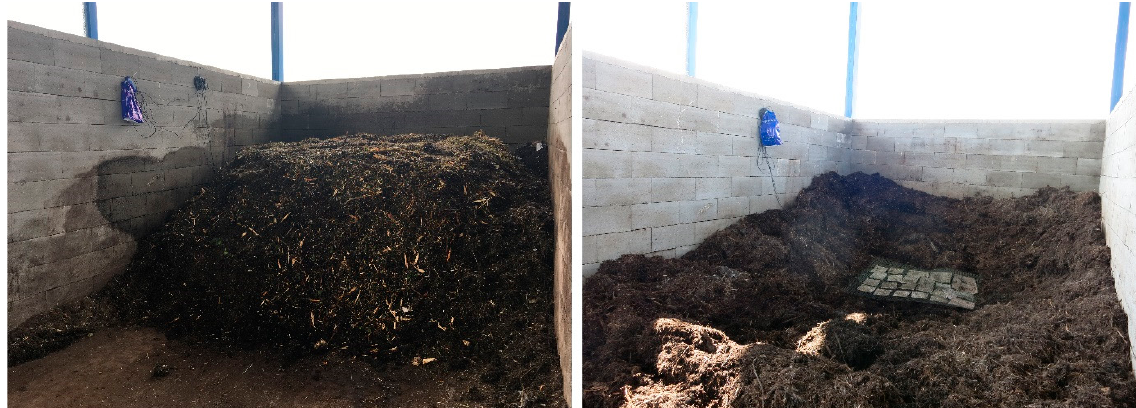
Figure 1. The compost pile and the plastic net with the cut samples. During the first cycle, only one specimen was tested from each sample. The average value of humidity during the entire monitored period was 39.3% (vol). The average value of inner temperature during the first cycle was 62.6 ◦ C. During the second cycle, two specimens were tested for each sample. The average humidity during the entire monitored period was 35% vol. The average inner temperature during the second cycle was 61.1 ◦ C.